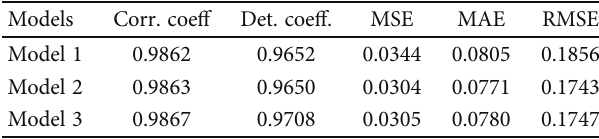
Table 3: Metrics results by input series size.